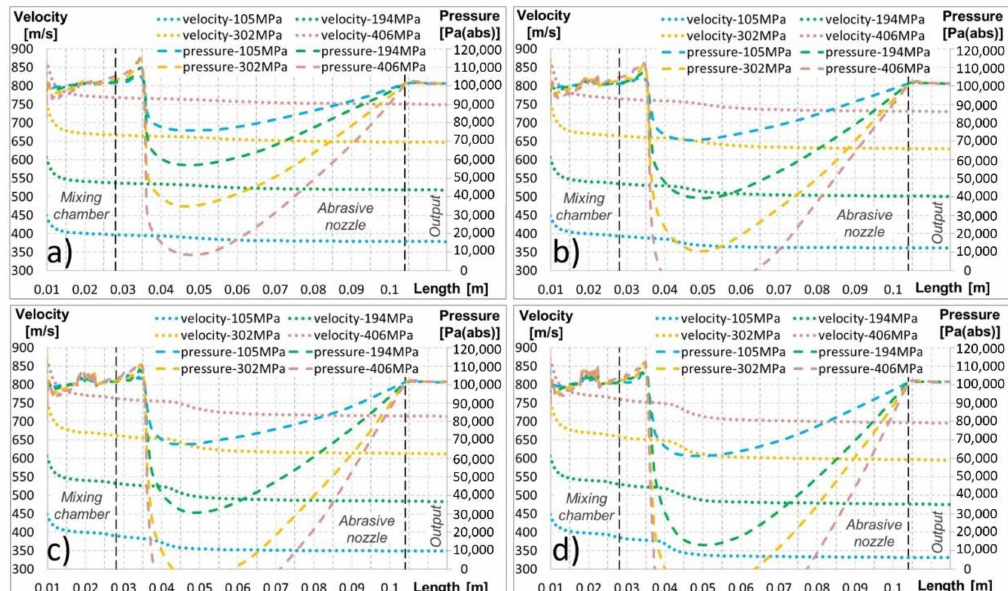
Figure 12. Calculated velocity and pressure distribution along the axis of the abrasive head, mixing chamber, focusing tube, and outlet: ( a ) abrasive mass flow rate of 100 g/min; ( b ) abrasive mass flow rate of 200 g/min; ( c ) abrasive mass flow rate of 300 g/min; ( d ) abrasive mass flow rate of 400